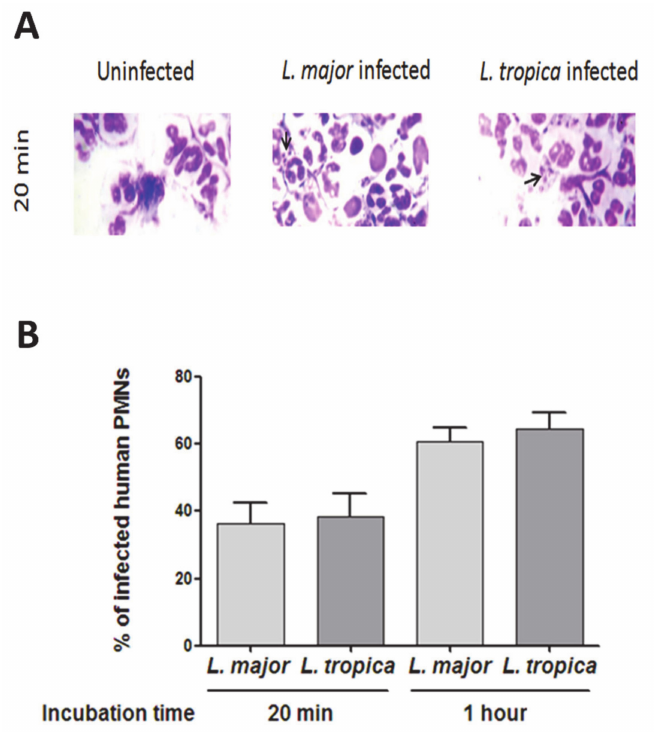
Figure 1. Infection rate of L. major and L. tropica primary strains in human PMNs. PMNs were cultured at 10 6 /mL, infected with L. major and L. tropica promastigotes at a 5:1 ratio, and incubated for 20 min at 37 ◦ C. ( A ) Cytocentrifuge preparations of uninfected and infected PMNs were stained with Giemsa for light microscopy. The original photomicrographs were taken at 1000x magnification. Arrows indicate the presence of intracellular parasites in PMNs infected by L. major and L. tropica strains and ( B ) infection rates of PMNs. Results are expressed as mean ± SEM from three independent experiments, each performed in duplicate. Data were analyzed using a one-way ANOVA test with a Tukey’s post-hoc test for multiple